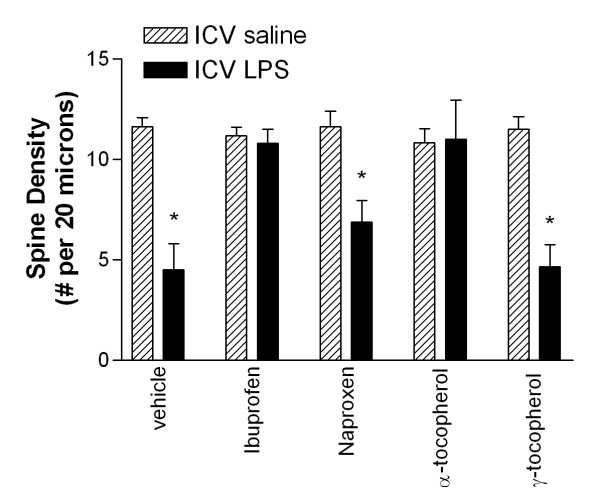
Pharmacologic suppression of dendritic degeneration in CA1 pyramidal neurons of mouse hippocampus. Adult (6 to 8 week old) wt C57Bl/6 mice received ICV saline or ICV LPS 24 hr prior to sacrifice. Tissue sections of hippocampus and surrounding structures were processed for Golgi stain and then evaluated by Neurolucida. Data are dendritic spine density for CA1 hippocampal pyramidal neurons (n > 6 neurons for each group). Two-way ANOVA had P < 0.001 for ICV saline vs. ICV LPS, effect of drugs, and interaction. Post hoc one-way ANOVA showed that no effect of drugs in ICV saline exposed mice. Ibuprofen and α-tocopherol completely protected spine density from ICV LPS exposure (P < 0.01 compared to vehicle treated mice) while naproxen and γ-tocopherol did not significantly protect (P > 0.05).